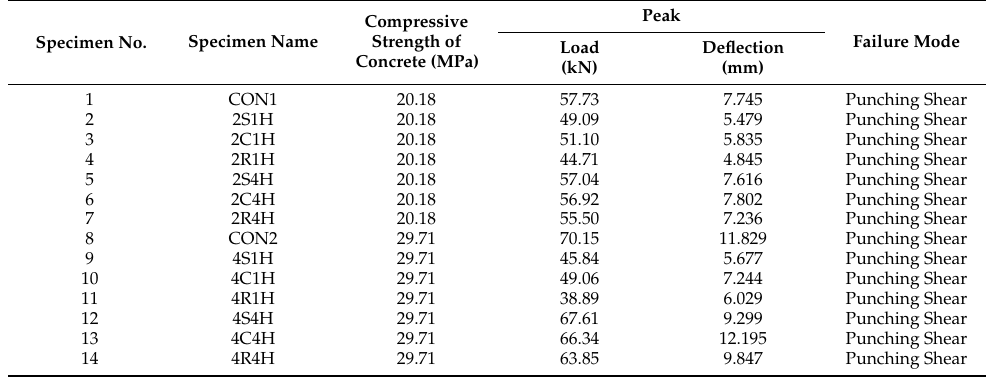
Table 3. Summary of test results.